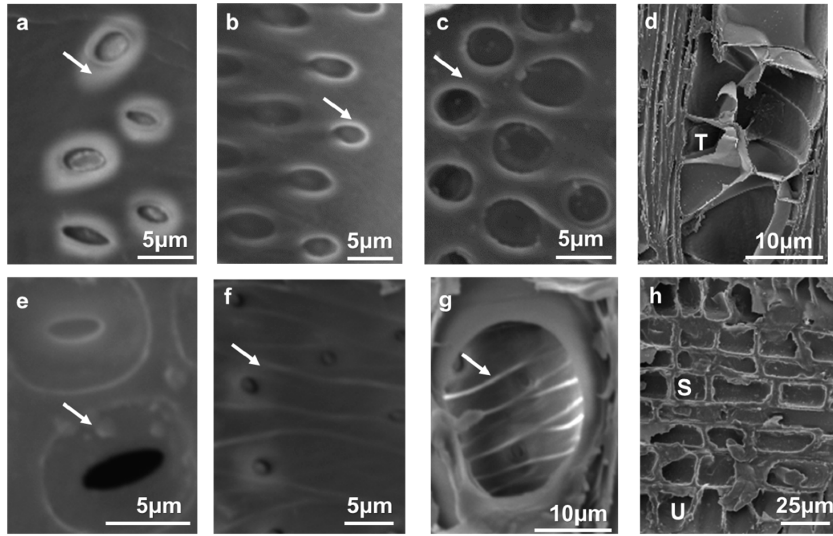
Figure 3. Scanning electron microscopy (SEM) photos of the radial and tangential sections of C. bungei in 1-1. ( a ) Intervessel pits with numerous depositions (arrow) in EW of the 2nd year; ( b ) intervessel pits with fewer depositions (arrow) in EW of the 7th year; ( c ) intervessel pits with rare depositions (arrow) in EW of the 12th year; ( d ) thin-walled tyloses in vessel elements; ( e ) warty layers in the pits (arrow) in EW of the 9th year; ( f ) the small pits in LW of the 9th year (arrow); ( g ) simple perforation plates and helical thickenings (arrow) in vessel elements; ( h ) ray cells heterocellular with one row of upright (U) and square marginal (S) cells.